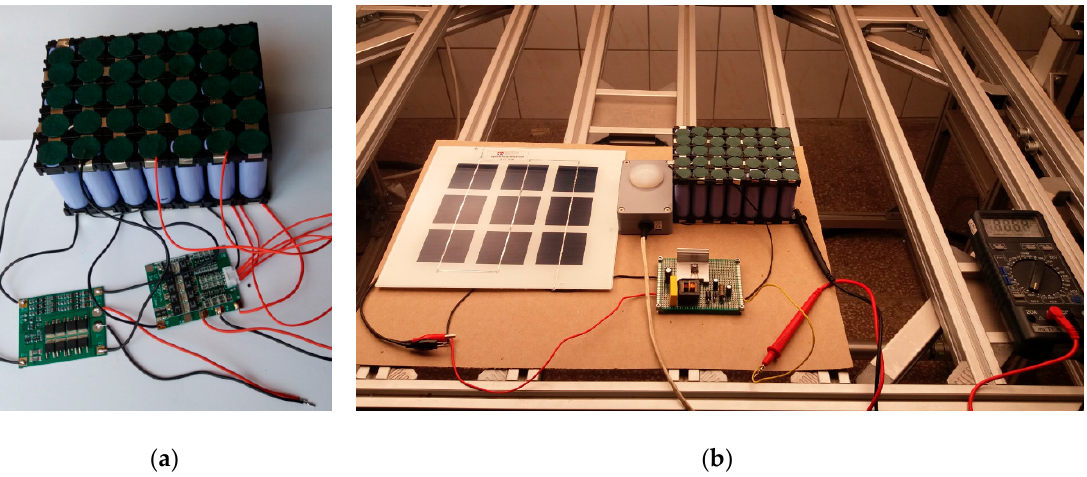
Figure 5. Image of battery management system (BMS) ( a ) and step-up converter ( b ) systems connected to a stack of batteries.